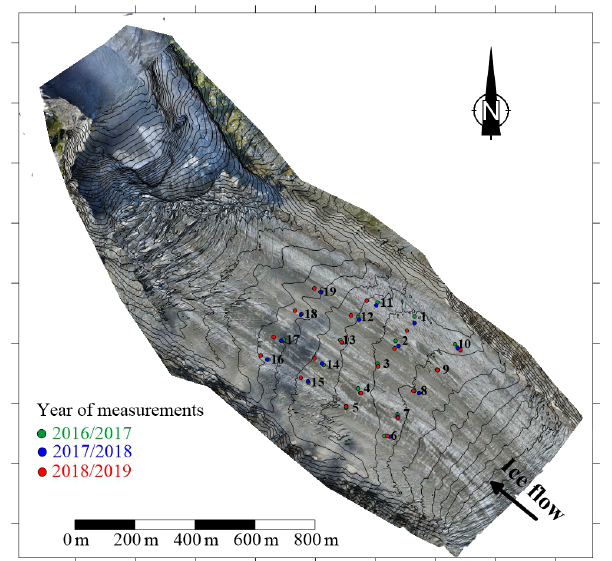
Figure 2. Map of the studied area in the ablation zone of the Argen- tière Glacier. The contour lines of surface topography correspond to the surface in 2018. The green, blue and red dots are the posi- tions of the ablation stakes used for surface mass balance and ice flow velocity measurements when they were set up in 2016, 2017 and 2018, respectively. Aerial photo from unmanned aerial vehicle survey (5 September 2018).